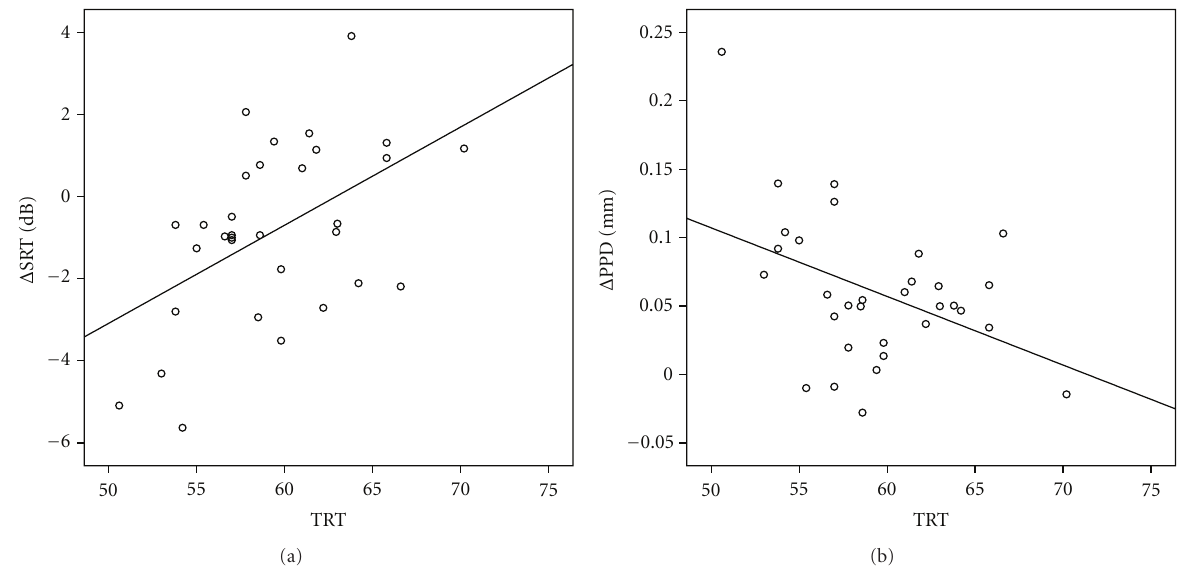
Figure 3: (a) TRT performance as function of Δ SRT [(ST50 + ST84 / 2) − (F50 + F84 / 2)]. (b) TRT as function of Δ PPD.